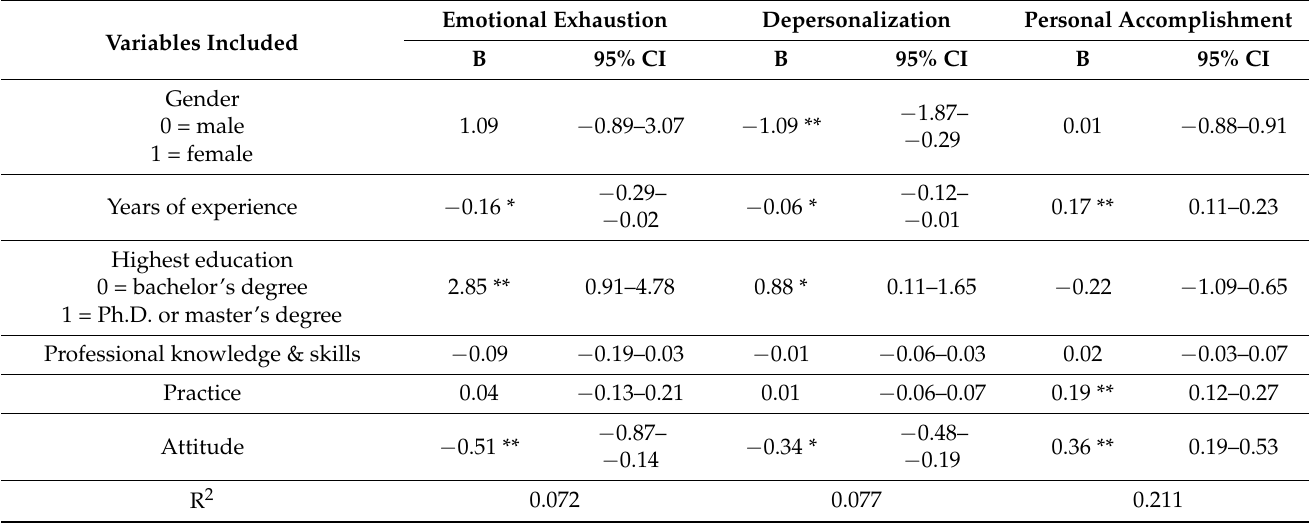
Table 3. Multiple linear regression models for the Maslach Burnout Inventory—Human Services Survey subscales (continuous variables).